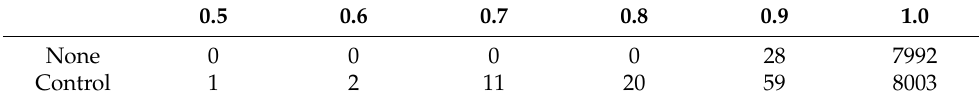
Table 2. The number of modes with zero signal reconstructed at various turbulent energy.